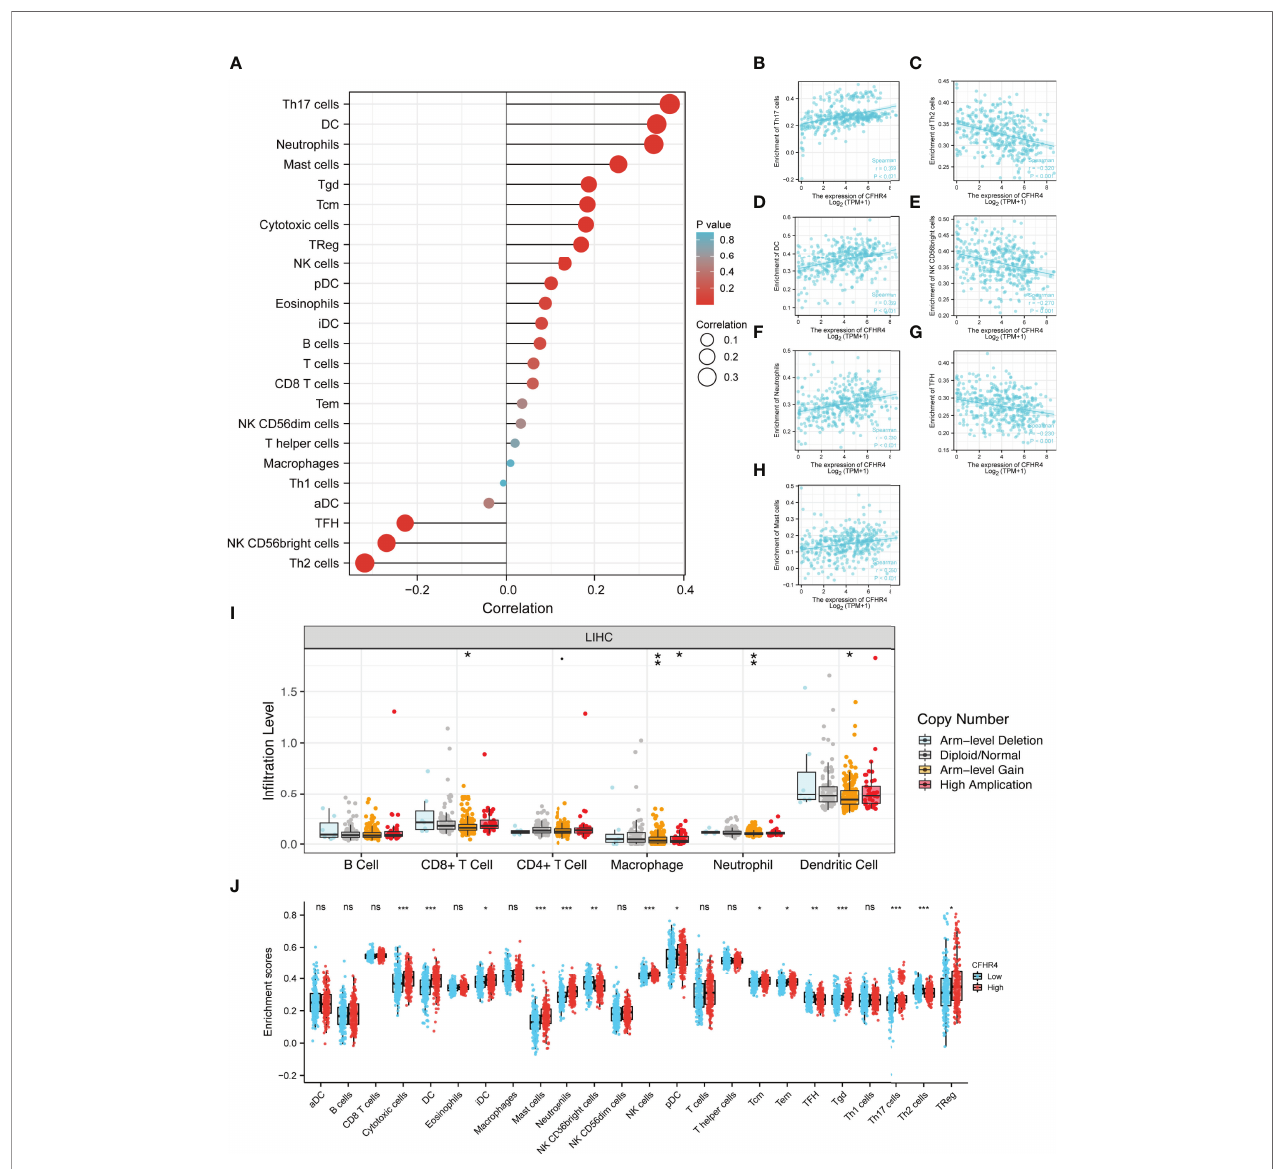
FIGURE 4 | Integrative analysis of CFHR4 expression in the in fi ltrating immune microenvironment. (A) The forest plot depicts the relationship between the level of CFHR4 expression and the relative abundances of 24 immune cells. (B – H) Scatter plots showing the differentiation of Th17 cells, Th2 cells, DCs, NK CD56bright cells, neutrophils, TFH cells and mast cells in fi ltration levels between high and low groups of CFHR4 expression. (I) The SCNA showed that CFHR4 expression correlated with the level of immune cell in fi ltration. (J) Scatter plots showing the correlations between 24 immune cells and CFHR4 expression levels. *p < 0.05, **p < 0.01, ***p < 0.001, NS, no signi fi